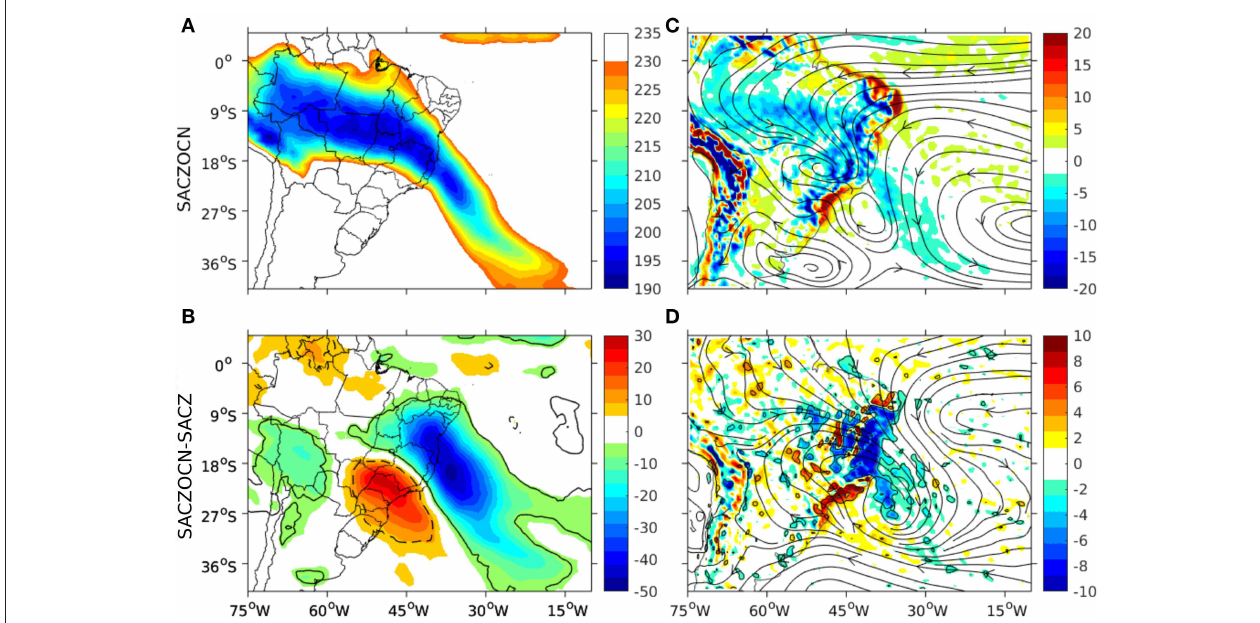
FIGURE 8 | Composites for oceanic SACZ (SACZOCN) days. (A) OLR (W m − 2 ). (C) divergence of water vapor flux (colors in × 10 8 s − 1 ) and streamlines in 850 hPa. (B,D) are the difference between continental (SACZ) and SACZOCN, with significant t -test values ( > 95%) inside the solid and dashed lines.